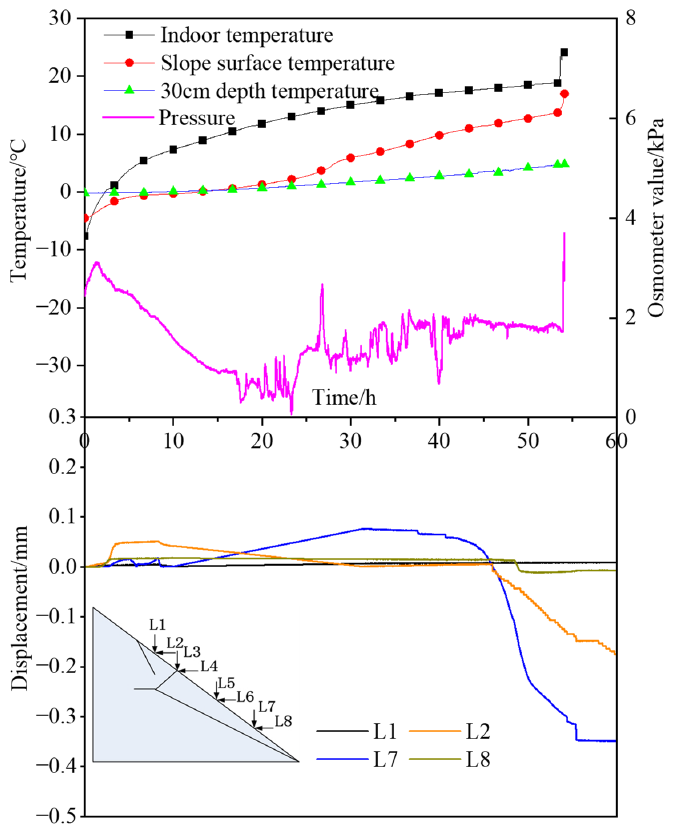
Figure 7. The variation curves of the measured variables during the heating process. The deformation form of the model slope after one freeze–thaw cycle is shown in Figure 8. A crack was formed at the bottom of the weak interlayer f3 due to frost-heave force. The crack propagates to the lower right side first, then develops into an arc to the lower left side. The crack turns to the rock mass’s sliding direction under the influence of the rock mass’s self-weight. The crack propagation depth is approximately 6 cm, and the crack tip is close to the model boundary.